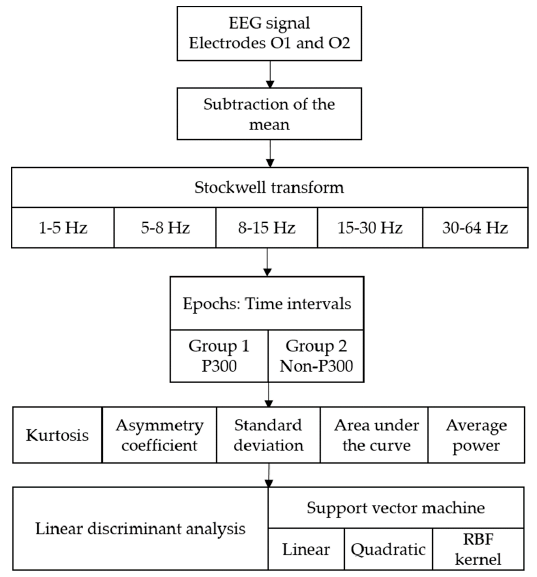
Figure 4. Methodology used in the processing of EEG signals.